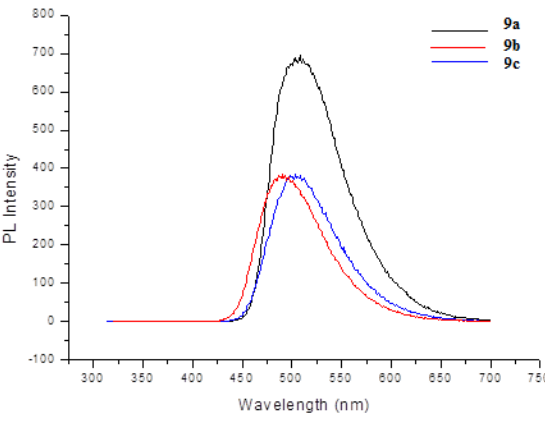
Figure 3. PL spectra of green dopants 9 .